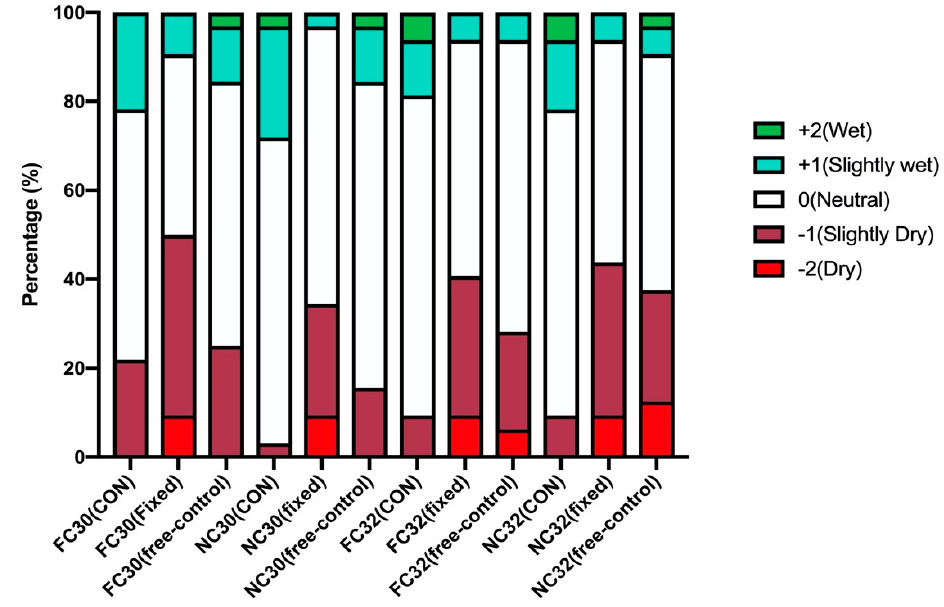
Figure 7. Ratings of dry lip symptoms in the 12 tested scenarios.